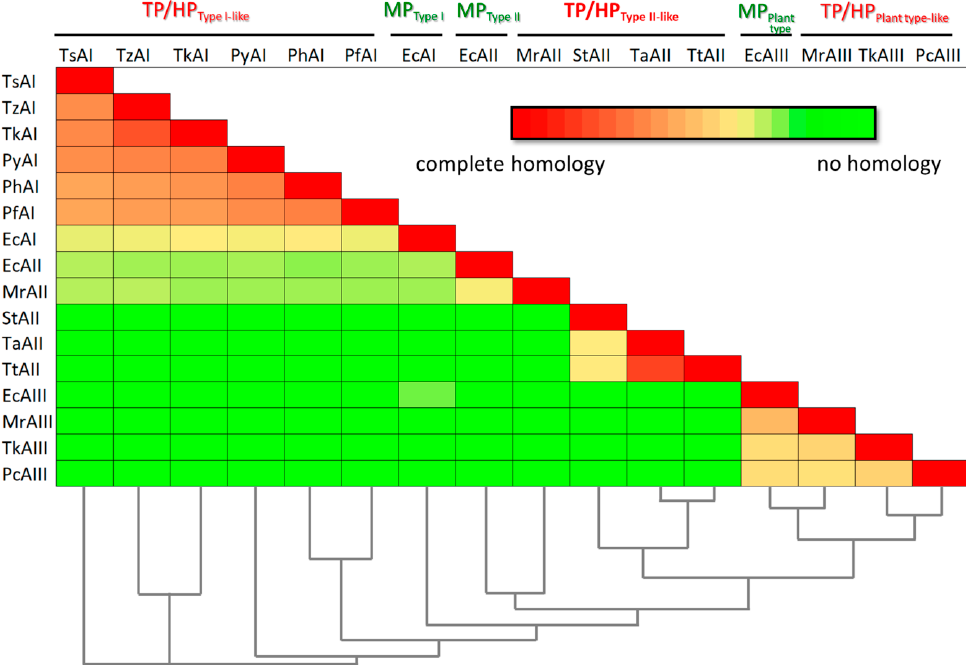
Figure 1. Amino acid identity matrix and phylogenetic relationships of mesophilic (MP),